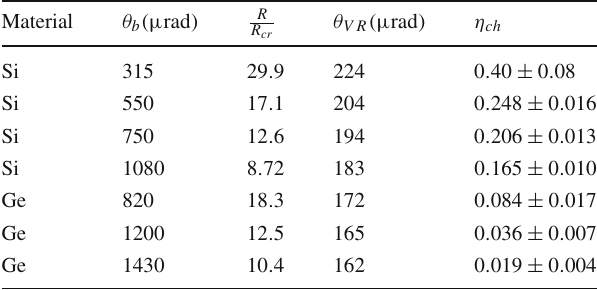
Fig. 5 The experimental and simulated depedences of channeling effi- ciency of Si and Ge crystals at optimal channeling orientation on the ratio of the bending radius to its critical value Table 1 Measured Si and Ge crystal bending radia, angles and chan- neling efficiency